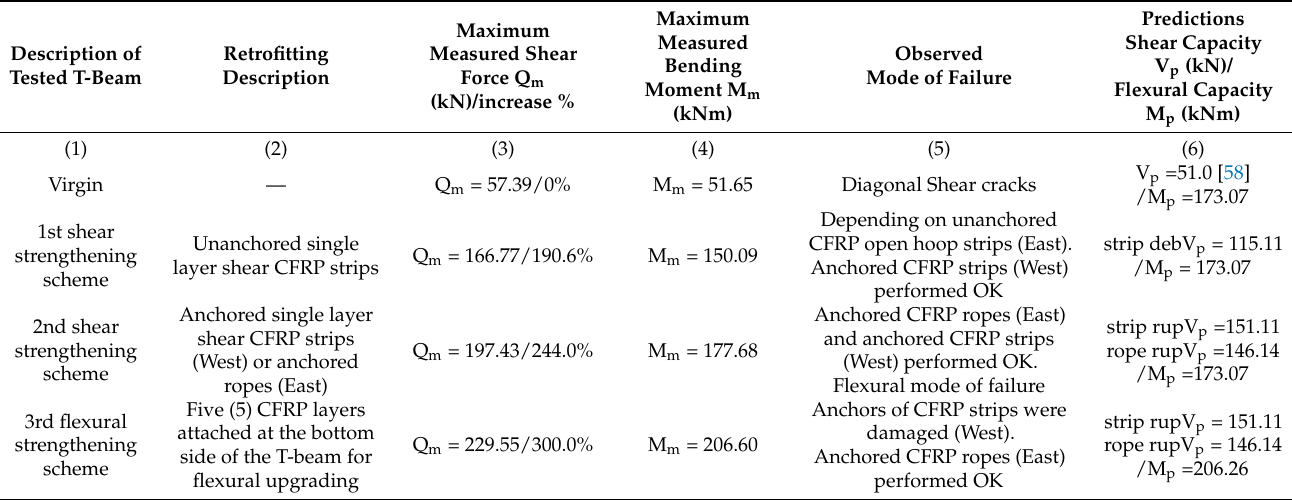
Table 5. Measured maximum shear force and bending moment values for the virgin and retrofitted specimen and corresponding predicted